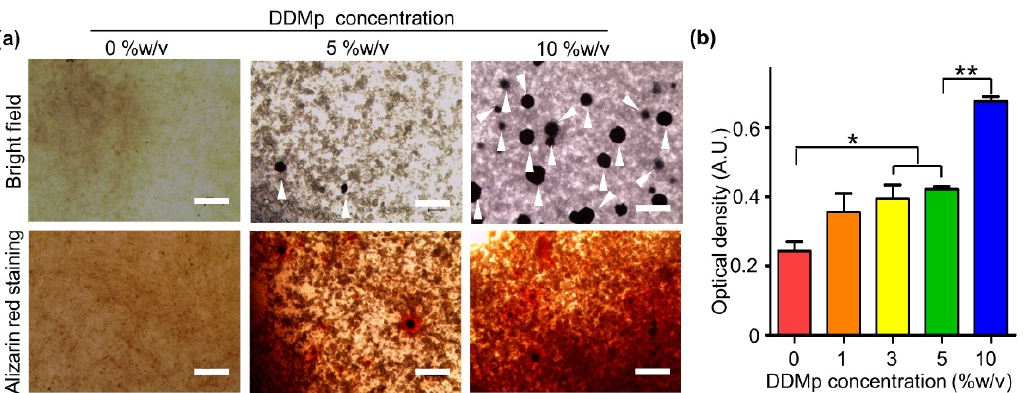
Figure 4. Odontogenic differentiation of DPSC-laden DDMp bio-ink. ( a ) Bright field microscopy images and alizarin red staining result of DPSC-laden DDMp bio-inks after culturing with differentiation medium for 15 days. White arrowheads indicate the formation of mineral nodules (Scale bar: 300 µ m). ( b ) Quantification result of alizarin red stained samples ( n = 4) (* p < 0.05; *** p < 0.001).